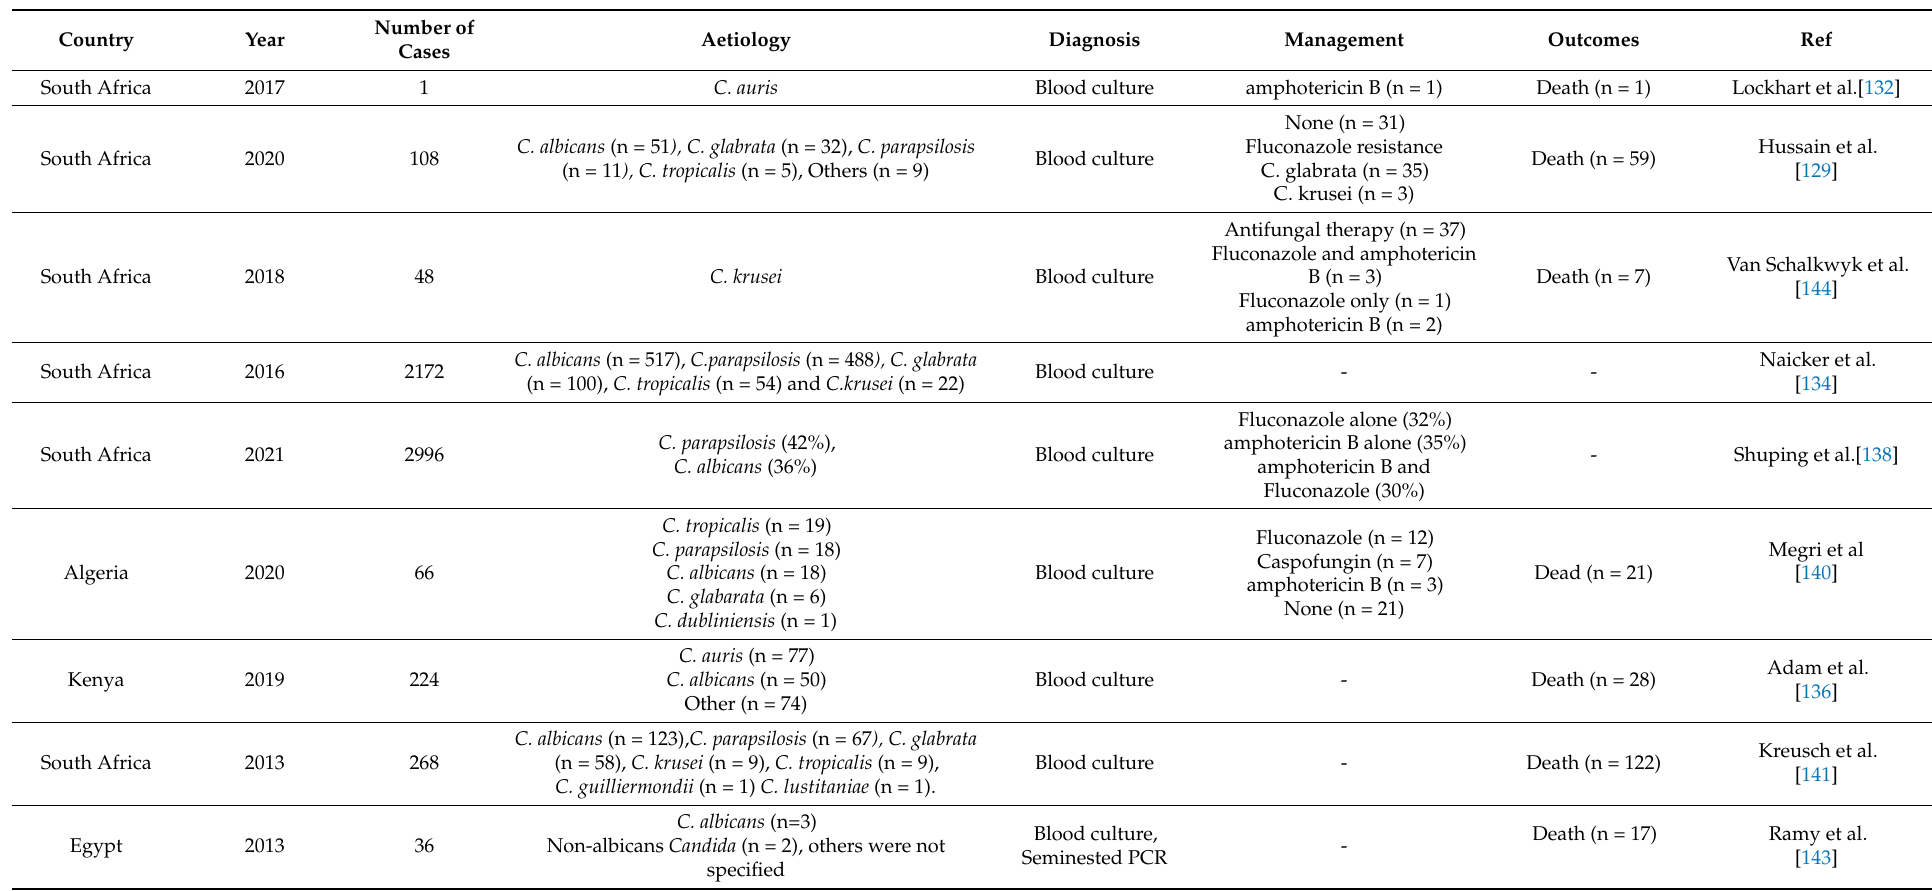
Table 5. Published cases of candidaemia in